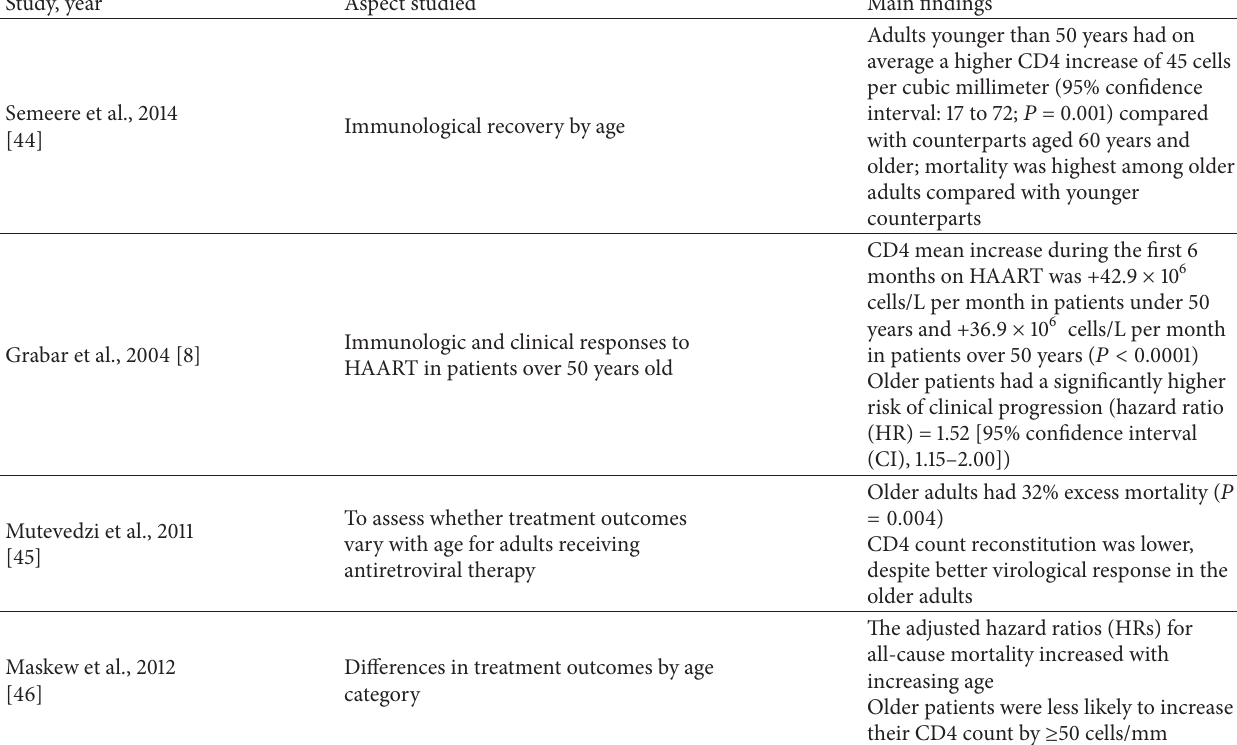
Table 1: Studies evaluating immunological and clinical responses to